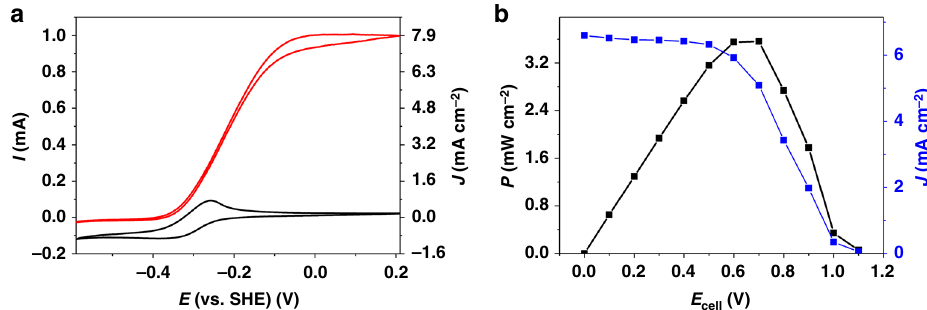
Fig. 4 Characterization of the high-current density biofuel cell. Electrochemical characterization of the high-current density P(GMA-BA-PEGMA)-vio//P (N 3 MA-BA-GMA)-vio/ Dv MF-[NiFe]-based bioanode in 0.1 M phosphate buffer (pH 7.4) as half-cell ( a ) under argon (black line) and H 2 (red line) atmosphere (scan rate: 10 mV s − 1 ) and in the gas-breathing biofuel cell coupled to a Mv -BOx-based cathode ( b ). a , Left ordinate: absolute current I ; right ordinate: current density J . b Power curve of the fully assembled one-compartment biofuel cell showing normalized power (left ordinate, black) and current values (right ordinate, blue). All measurements were conducted in gas-breathing mode. For the calculation of normalized current and power values, the spot size of the polymer layer was used, which was determined to be ≈ 4 mm. The biofuel cell reveals an open circuit voltage of 1.1 V and a maximum power density of 3.6 mW cm − 2 at 0.7 V. Nominal hydrogenase loading: 4 nmol/31.8nmol cm − 2 . P(N 3 MA-BA-GMA)-vio poly(3-azido-propyl methacrylate- co -